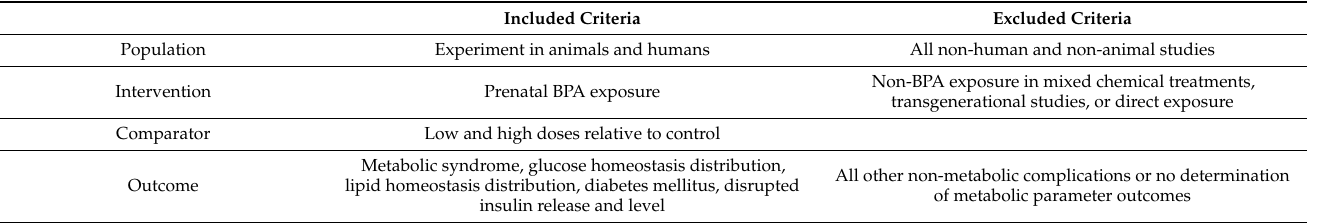
Table 1. Patient, intervention, comparator, and outcome (PICO) criteria for inclusion and exclusion. Included